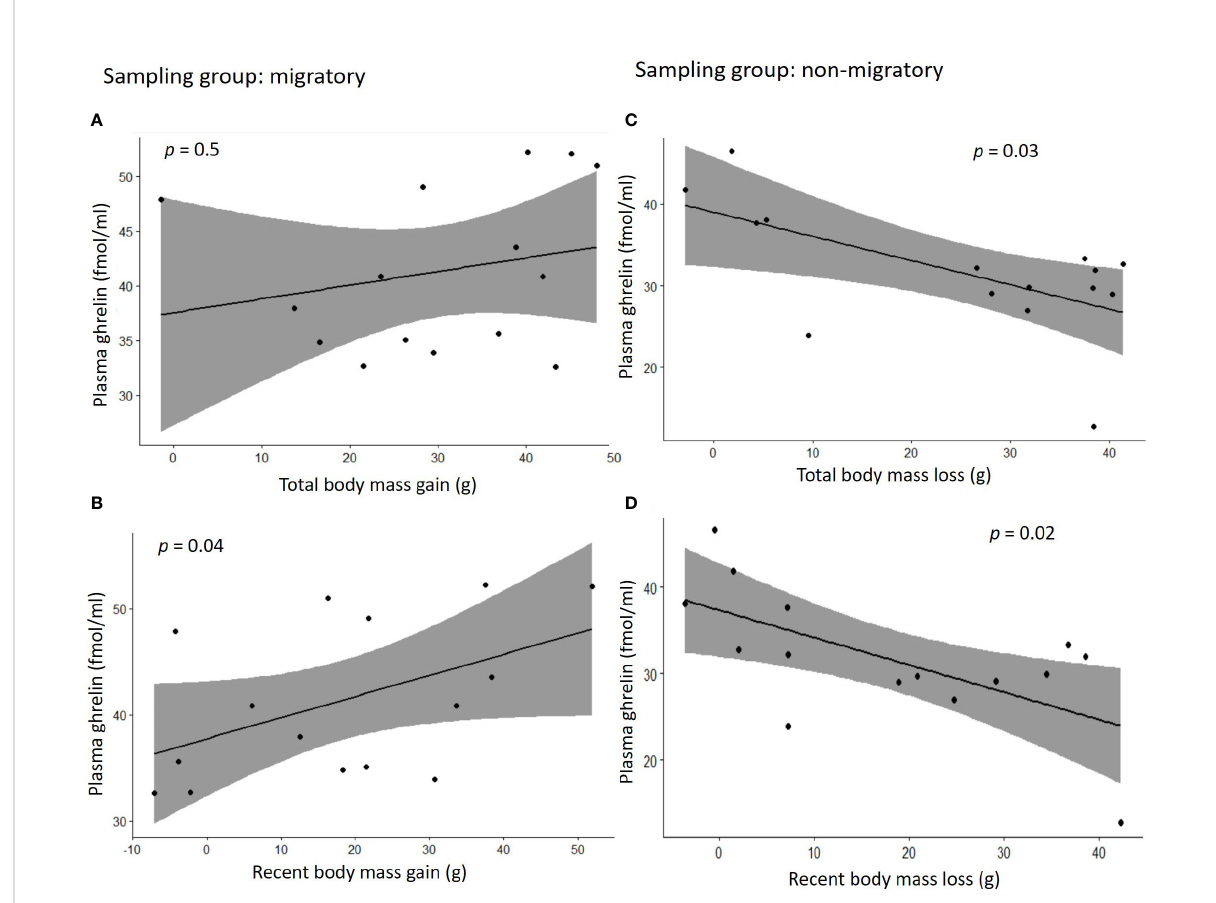
FIGURE 3 Correlation plots between concentrations of plasma ghrelin and changes in body mass during the migratory phase (A, B) or the non-migratory phase (C, D) . In (A) the total body mass gain was calculated as the difference in body mass between the time in which migratory birds were singly housed for blood sampling (experimental days 56-70) and experimental day 0; in (B) the recent body mass gain was calculated as the difference in body mass between the day of single housing and experimental day 42; in (C) the total body mass loss is the difference between the time in which non-migratory birds were singly housed for blood sampling (experimental days 105-119) and experimental day 70, and in (D) the recent body mass loss was calculated as the difference in body mass between the day of single housing and experimental day 91. Grey area in the graphs represents 95% con fi dence